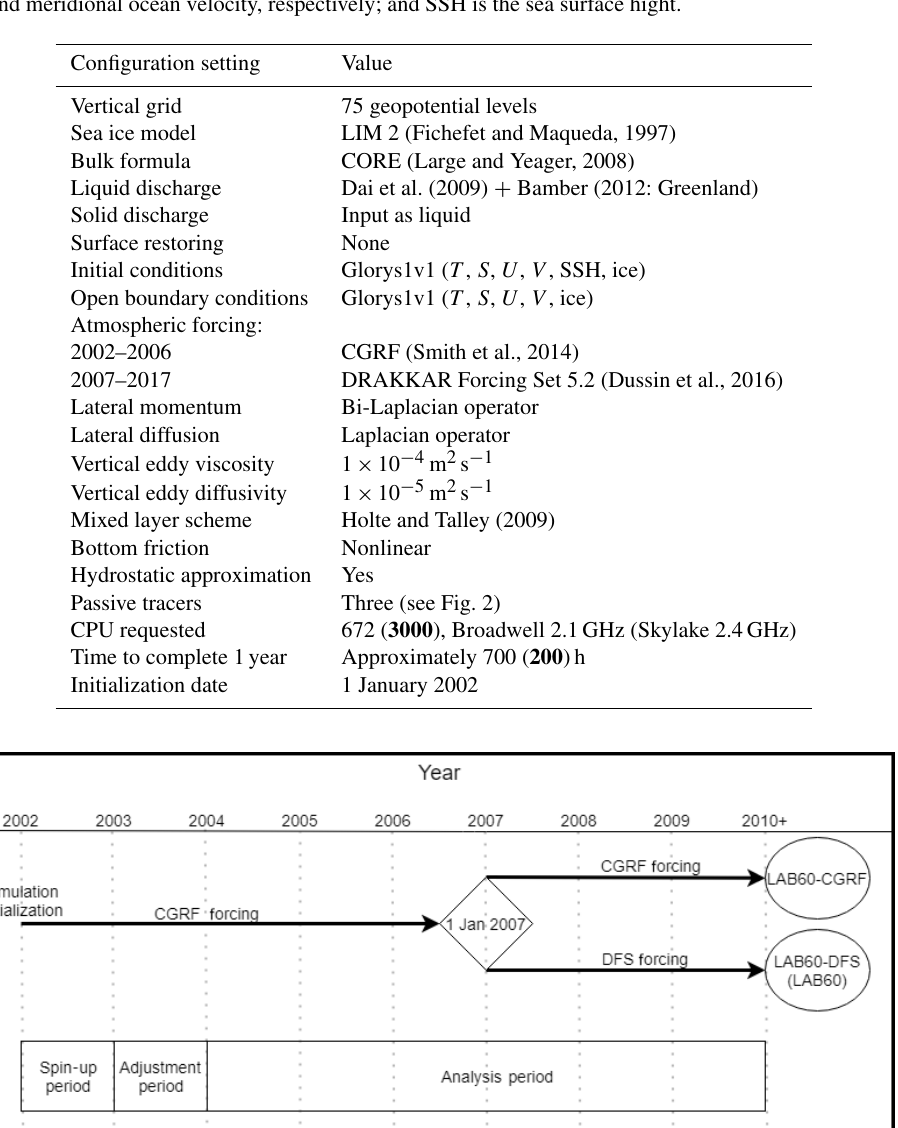
Table 2. Model configuration settings that are identical between all three domains. Bold values indicate values that were changed when we migrated LAB60 from the Graham cluster to Niagara. The abbreviations used in the table are as follows: T is temperature; S is salinity; U and V are the zonal and meridional ocean velocity, respectively; and SSH is the sea surface hight.